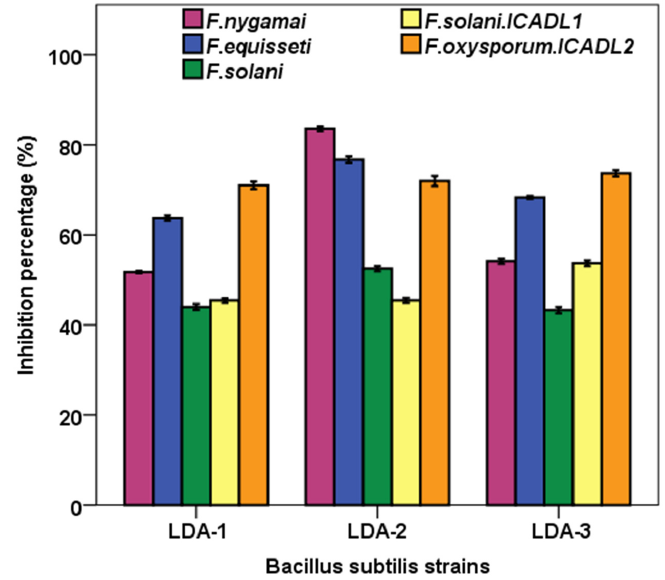
Figure 4. Growth inhibition of phytopathogenic fungi by B. subtilis strains isolated from the rhizo- sphere of P. glandulosa plants, in dual-plate assay. Values = mean ± SE, (n = 3).